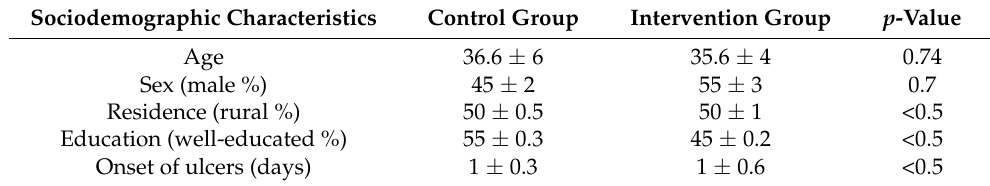
Table 2. Sociodemographic analysis of participants.